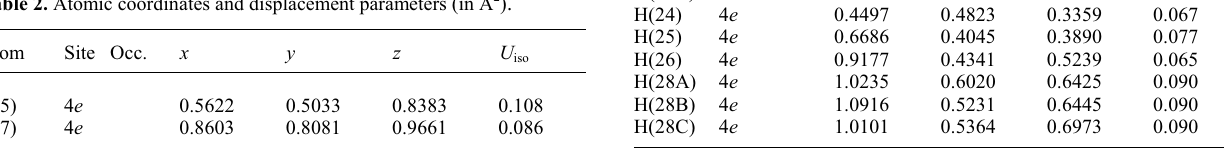
Table 2. Atomic coordinates and displacement parameters (in Å 2 ) .